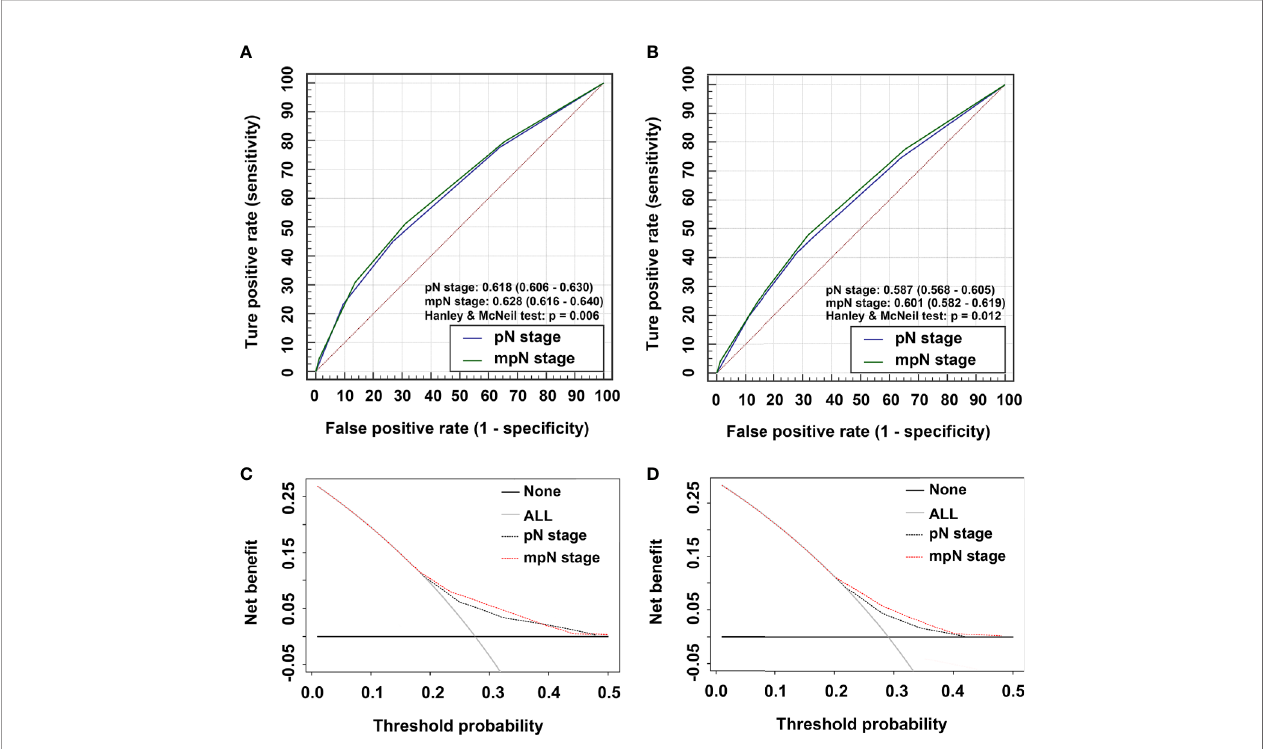
FIGURE 5 | Time-dependent areas under receiver-operating characteristic (ROC) curves (AUC) and Decision curve analysis (DCA) for overall survival (OS). AUCs for (A) pathological N (pN) stage and modi fi ed pN (mpN) stage in the training cohort and (B) pN stage and mpN stage in the validation cohort. DCAs for 5-year OS in (C) the training cohort and (D) the validation